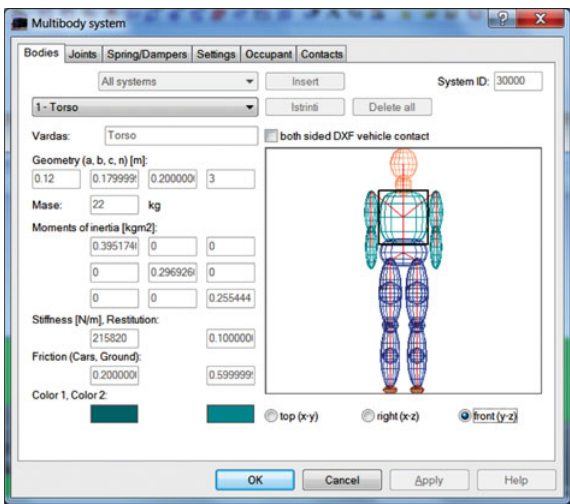
Fig. 11. The parameters of pedestrian ( PC-Crash